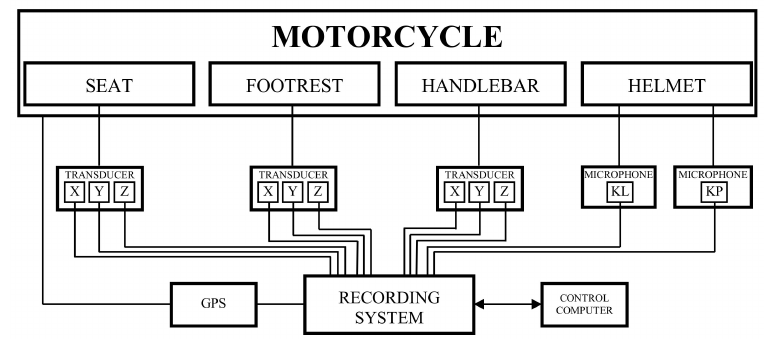
Figure 4. Measuring system